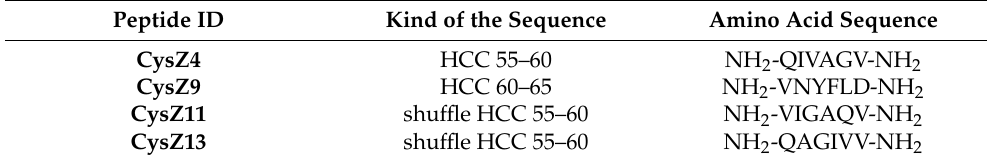
Table 1. Amino acid sequences of the peptides. Peptide